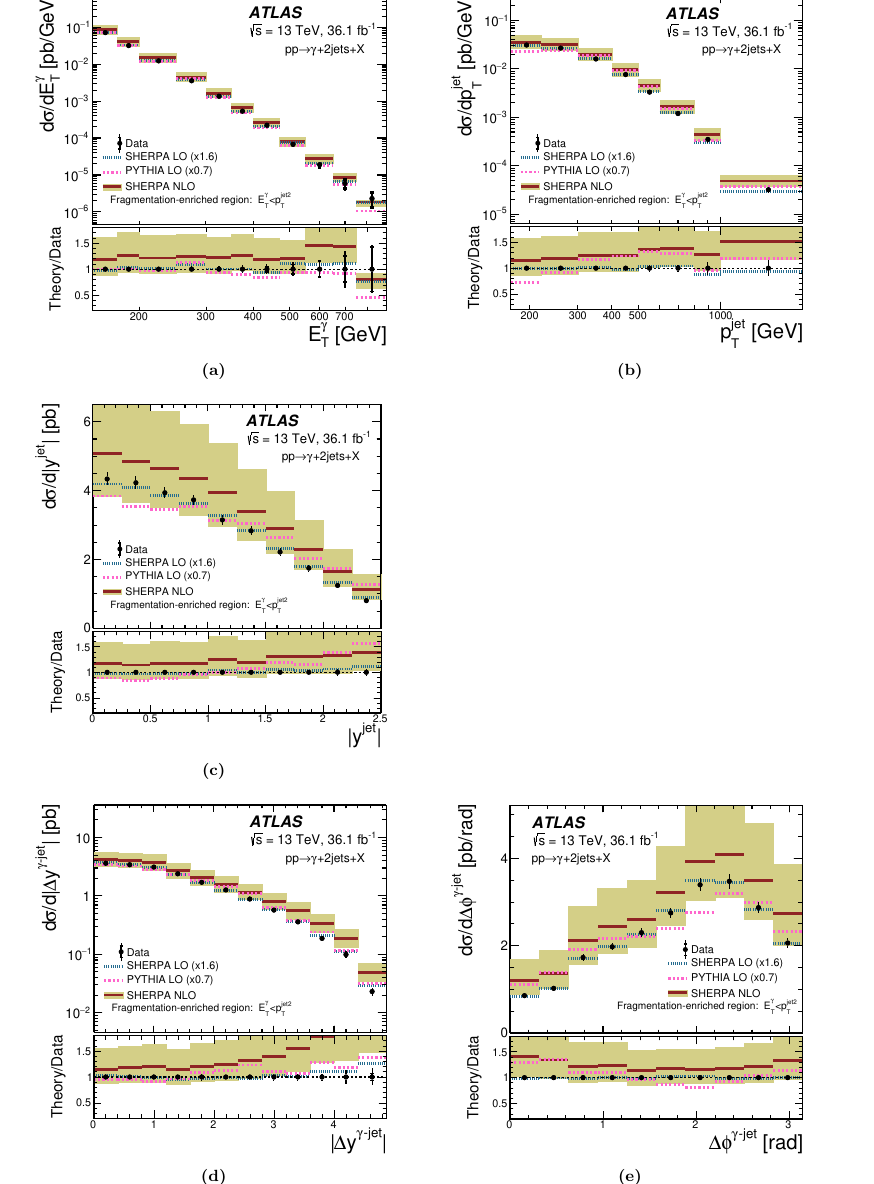
Figure 6 . Measured cross sections for isolated-photon plus two-jet production (dots) as functions of (a) E (cid:13) , (b) p jet , (c) j y jet j , (d) j (cid:1) y (cid:13) {jet j and (e) (cid:1) (cid:30) (cid:13) {jet for the fragmentation-enriched phase space. T T The NLO QCD predictions from Sherpa (solid lines) based on the NNPDF3.0 PDFs are also shown. The tree-level plus parton-shower predictions from LO Sherpa (dotted lines) and Pythia (dashed lines) normalised to the integrated measured cross section (using the factors indicated in parentheses) are also shown. The bottom part of each (cid:12)gure shows the ratio of the predictions to the measured cross section. The inner (outer) error bars represent the statistical uncertainties (the statistical and systematic uncertainties added in quadrature) and the (cid:12)lled bands represent the theoretical uncertainty of the NLO QCD predictions. For most of the points, the inner and outer error bars are smaller than the marker size and, thus, not visible. The visible thin error bars represent the outer error